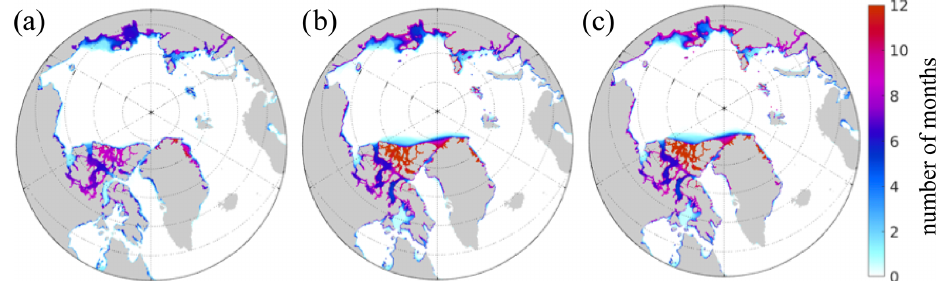
Figure 9. A 6-year average of the number of months per year during which the ice is landfast (a) obtained from the NIC charts and extensions, (b) with the LKD parameterization and (c) the ProbSI model with σ b = 2 . 5m.